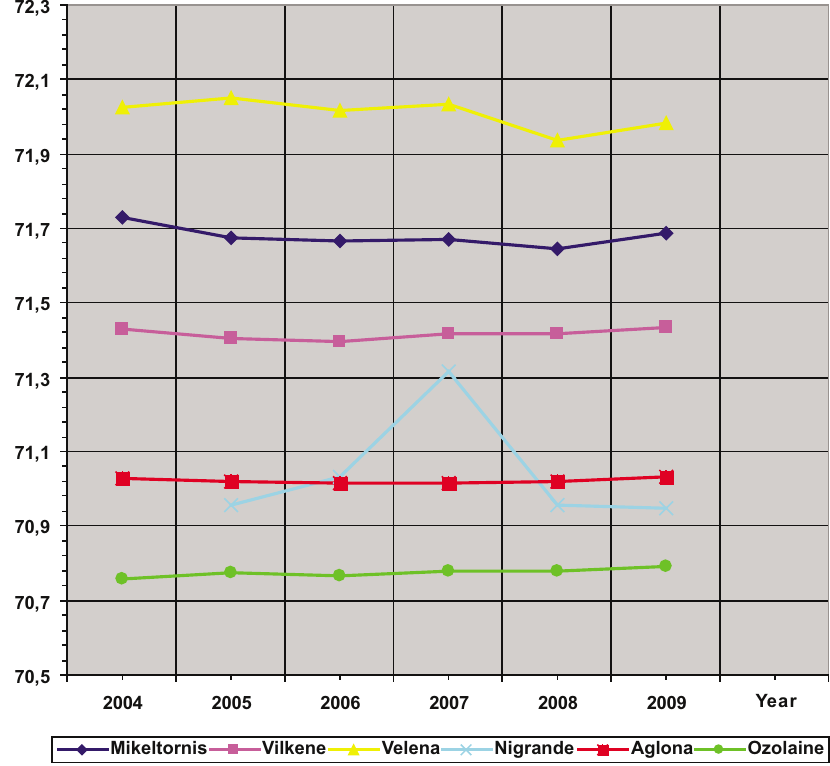
Fig. 4. The variation of inclination mean annual values in degrees (during